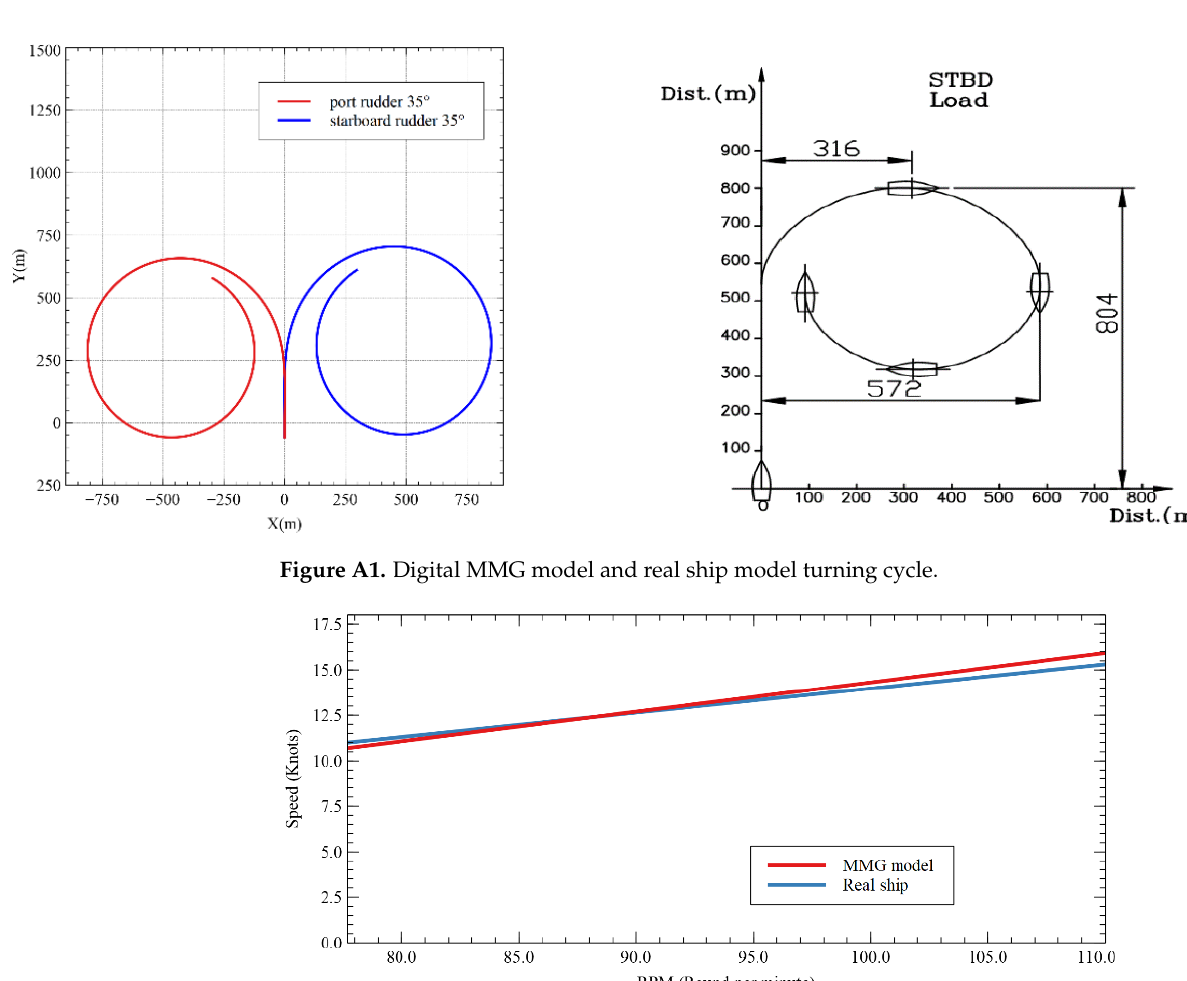
Figure A2. Comparison of speed performance between MMG model and real ship.